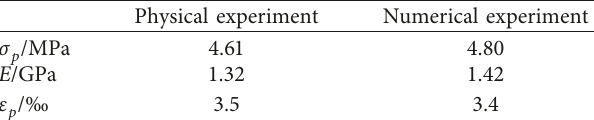
Table 3: Comparison of characteristic parameters.